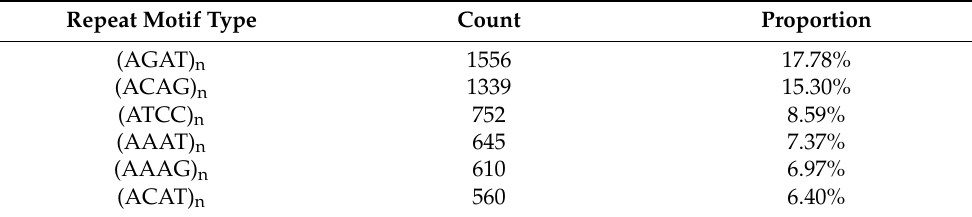
Figure 2. Distribution of microsatellite repeat motif types in the P. fluviatilis genome. Different colors represent the repeat times of different core sequences. ( a ) Type and number of dinucleotide core repeats. ( b ) Type and number of trinucleotide core repeats. ( c ) Type and number of tetranucleotide core repeats. ( d ) Type and number of pentanucleotide core repeats. Table 2. Repeat motifs and the proportion of tetranucleotide-repeat microsatellite loci in the P. fluviatilis